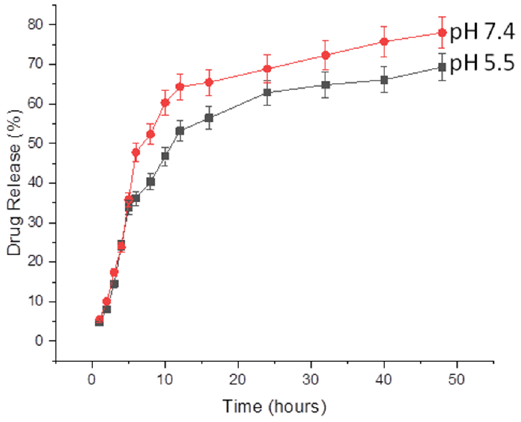
Figure 5. Release of oil from CEO-encapsulated NFs at pH 5.5 and pH